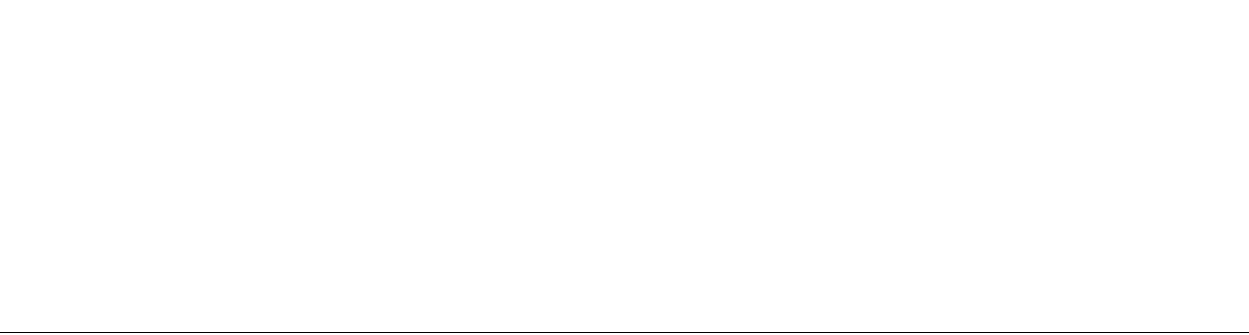
Frontiers in Plant Science | Plant